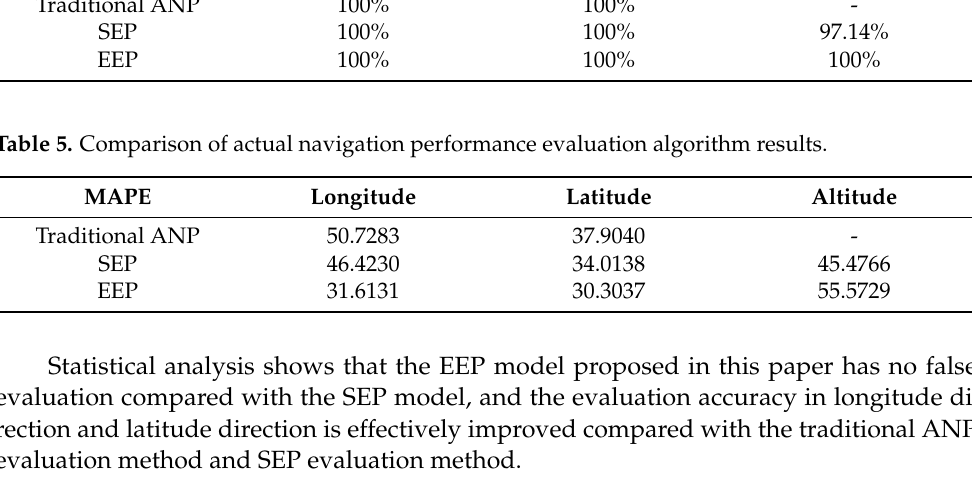
Table 4. Comparison of actual navigation performance evaluation algorithm results.